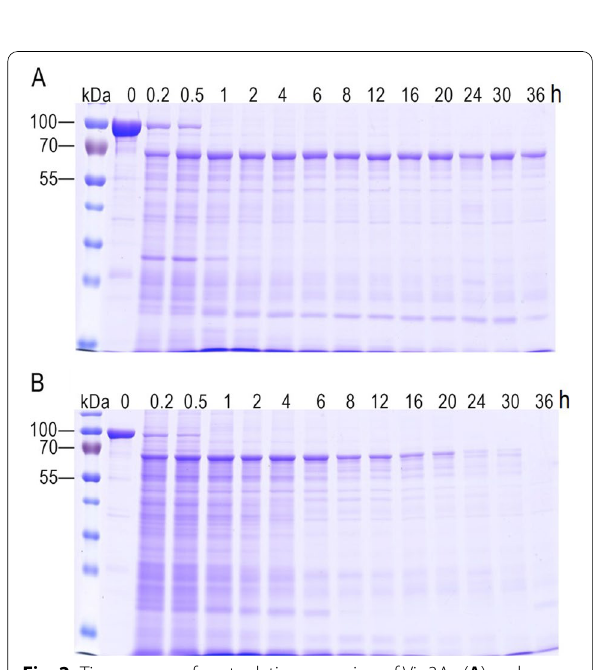
Fig. 2 Time course of proteolytic processing of Vip3Aa ( A ) and Vip3Ad ( B ) by S. exigua midgut